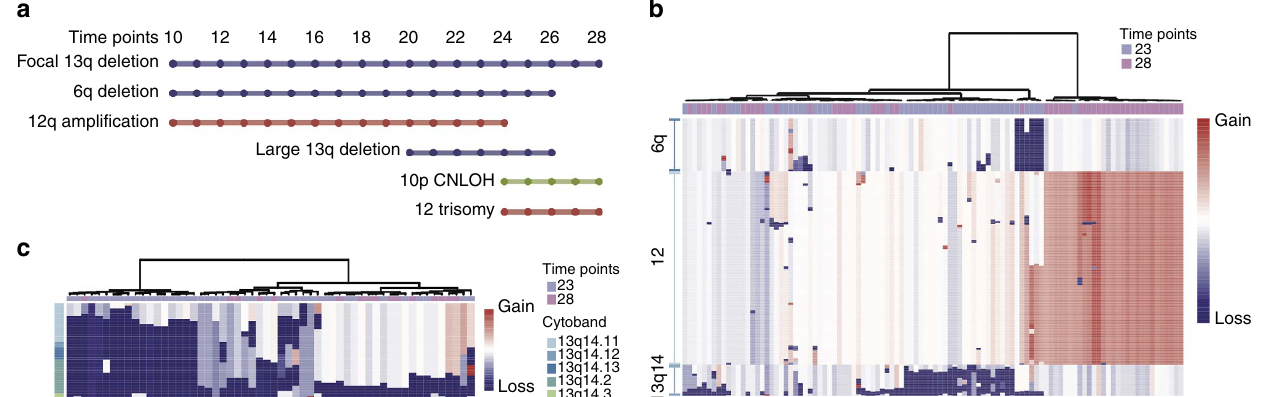
Figure 3 | CNV profiles detected by WGS and single-cell WGS. ( a ) The timeline of CNVs detected by combined SNP microarray and WGS. CNLOH, copy-neutral loss of heterogeneity. ( b ) The CNV profiles of 6q, 12 and 13q14 by single-cell WGS. Two cells were removed (Supplementary Figs 11 and 12). ( c ) The CNV profiles of the 13q14 region. The cells with a normal karyotype in this region were removed. The CNV profiles of all cells were showed in Supplementary Fig. 10b.